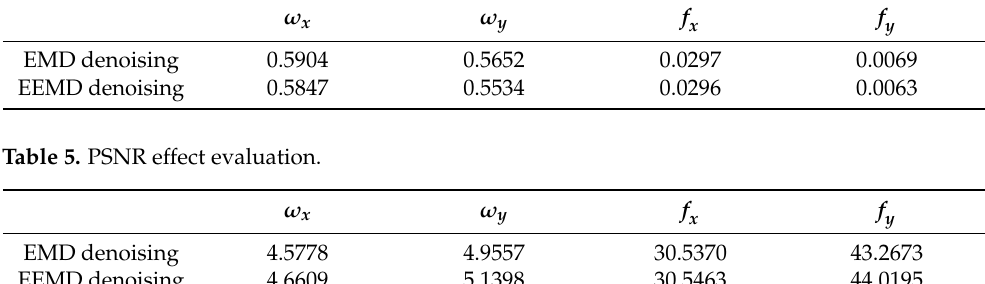
Table 4. RMSE effect evaluation.